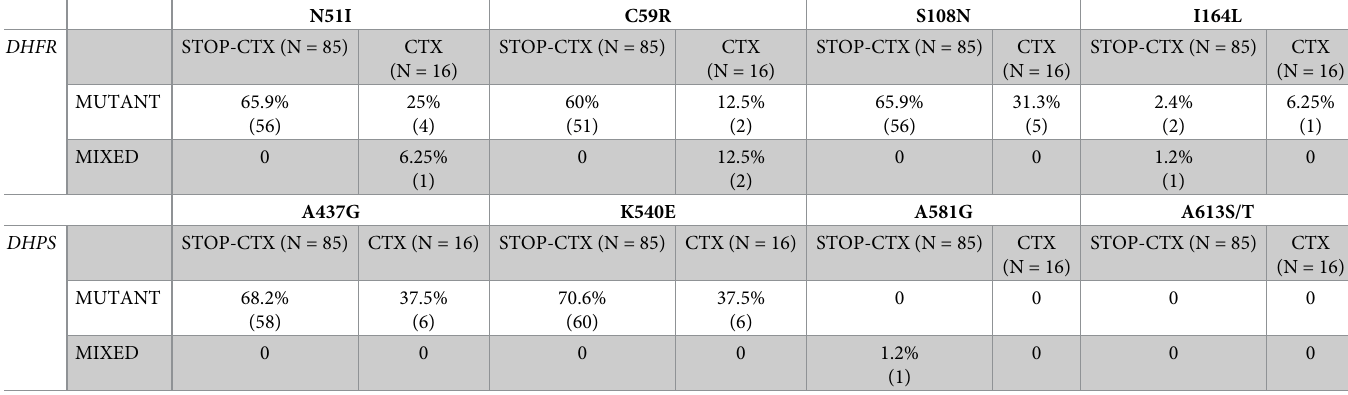
Table 1. Prevalence of mutations in the pfdhfr and pfdhps genes.